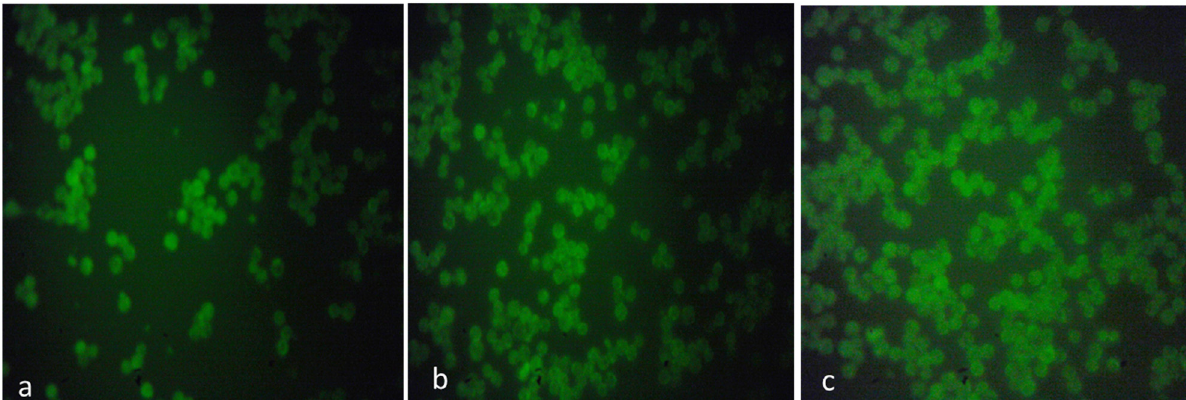
Figure 10: Dysfunction of mitochondrial membrane potential in MOLT4 cells after treatment with ZnO – TiO 2 – chitosan – escin bio - nano - composites. The mitochondrial membrane potential was determined by Rhodamine 123 nuclear staining. ( a ) Untreated control cells, ( b ) cells treated with 30 μ g · mL − 1 , and ( c ) 40 μ g · mL − 1 of ZnO – TiO – chitosan – escin bio - nanocomposites. These are representative images of 2 the experiment performed in triplicates with magni fi cation at 20 × .